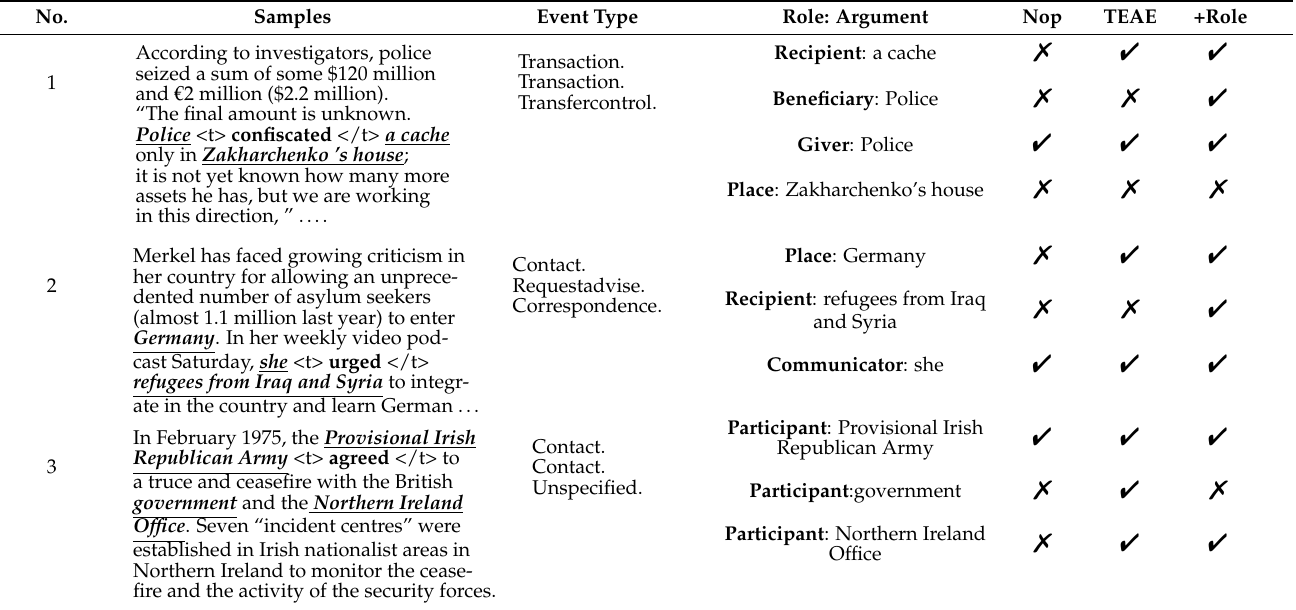
Figure 5. Effectiveness of role knowledge on model accuracy. RAMS(+role) and RAMS(- role) denote models with and without role knowledge on dataset RAMS, respectively, and WIKIEVENTS(+role) and WIKIEVENTS(-role) denote models with and without role knowledge on dataset WIKIEVENTS, respectively. Table 4. Case study. Bold black is the trigger word, and bold black with underlining is the argu- ment. “Nop” means the model did not have a prompt. “TEAE” means using a prompt template containing the role definition and event description, and “+role” means using a prompt with role knowledge